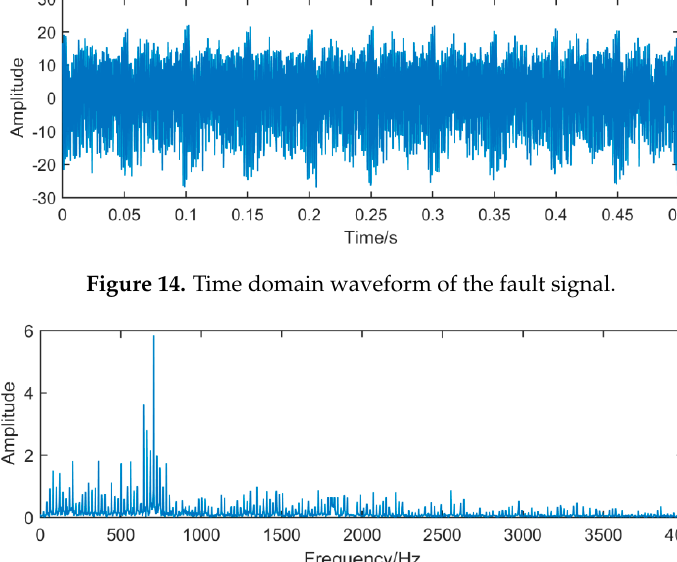
Figure 15. Frequency domain waveform of the fault signal.